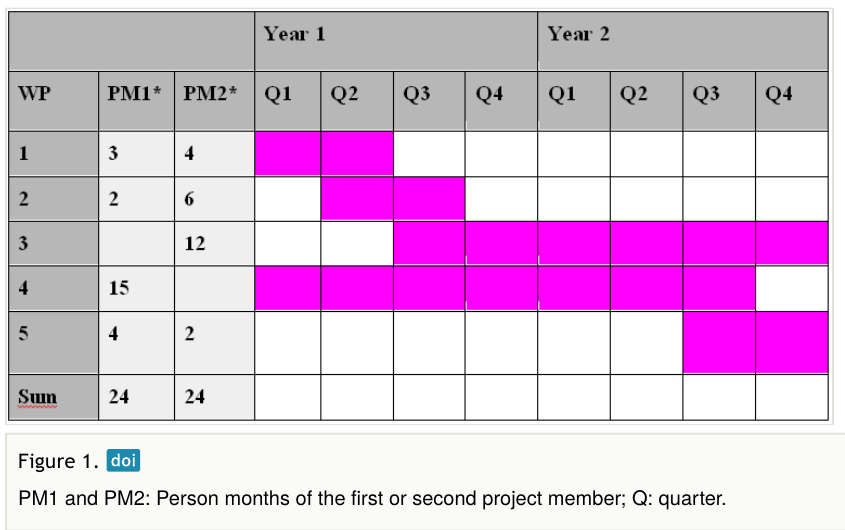
PM1 and PM2: Person months of the fi rst or second project member; Q: